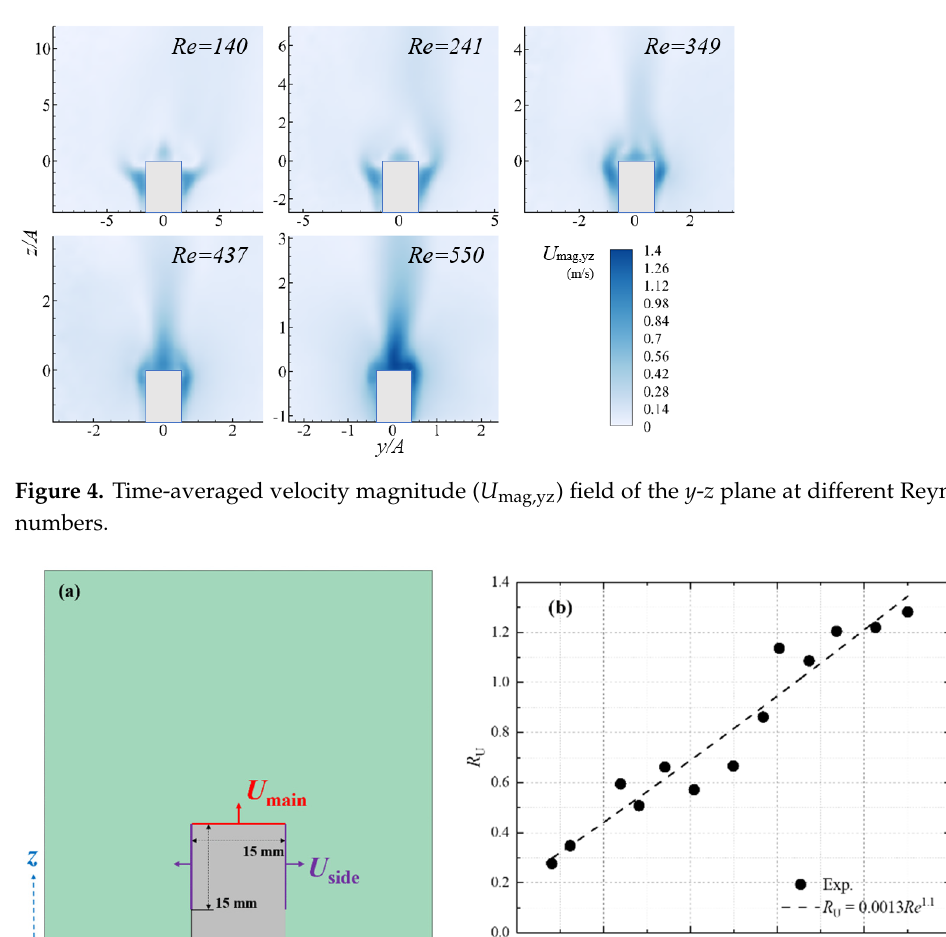
Figure 4. Time-averaged velocity magnitude ( U mag, yz ) field of the y – z plane at different Reynolds numbers.